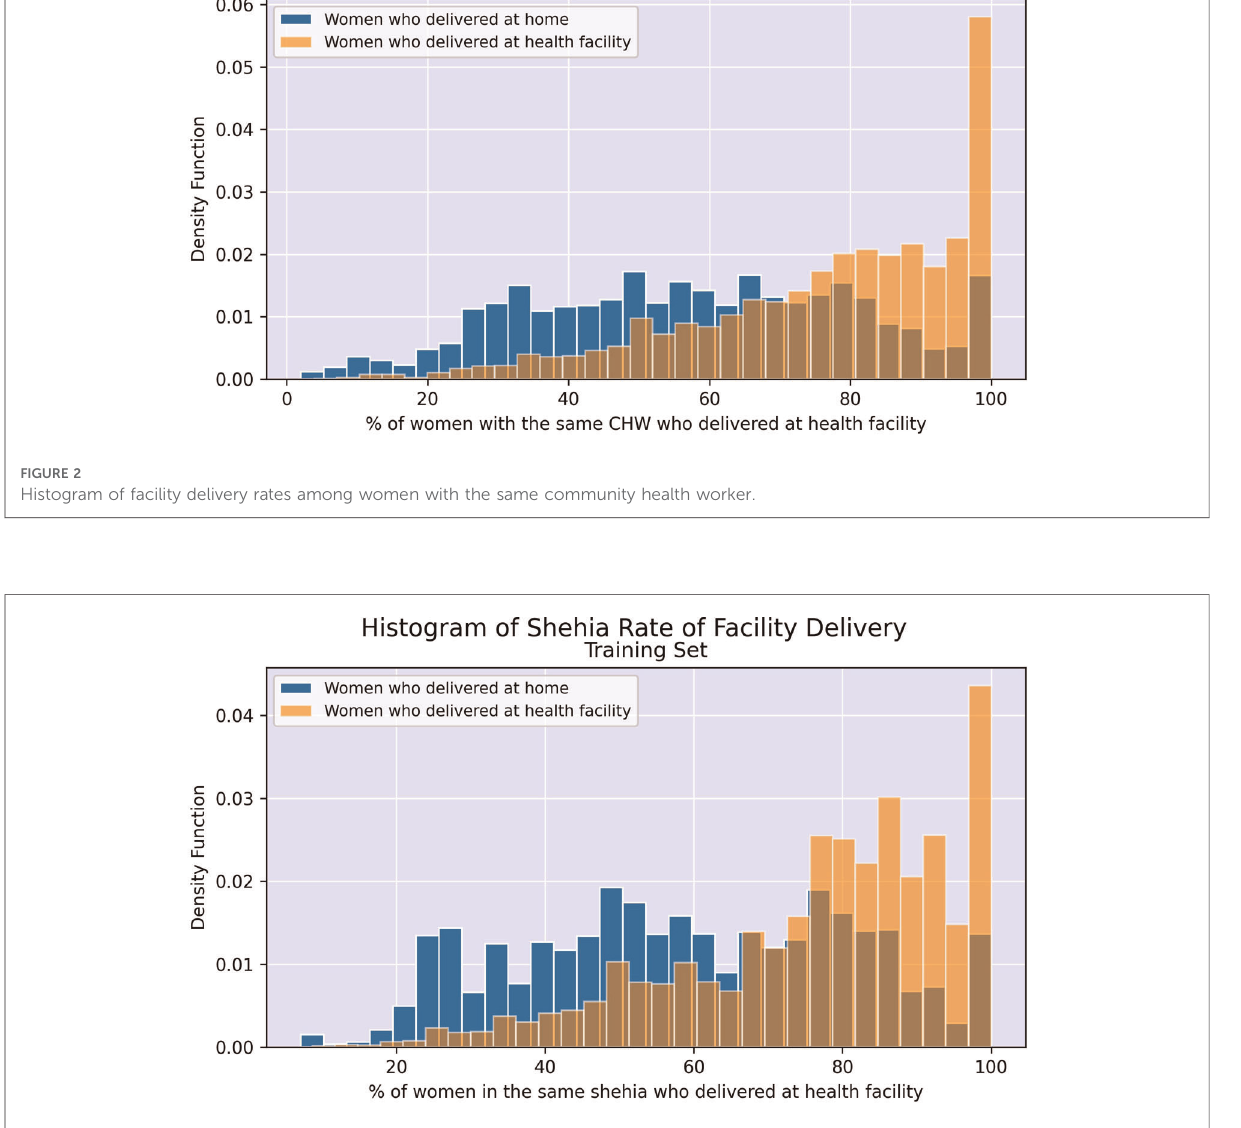
FIGURE 3 Histogram of facility delivery rates among women in the same shehia (local